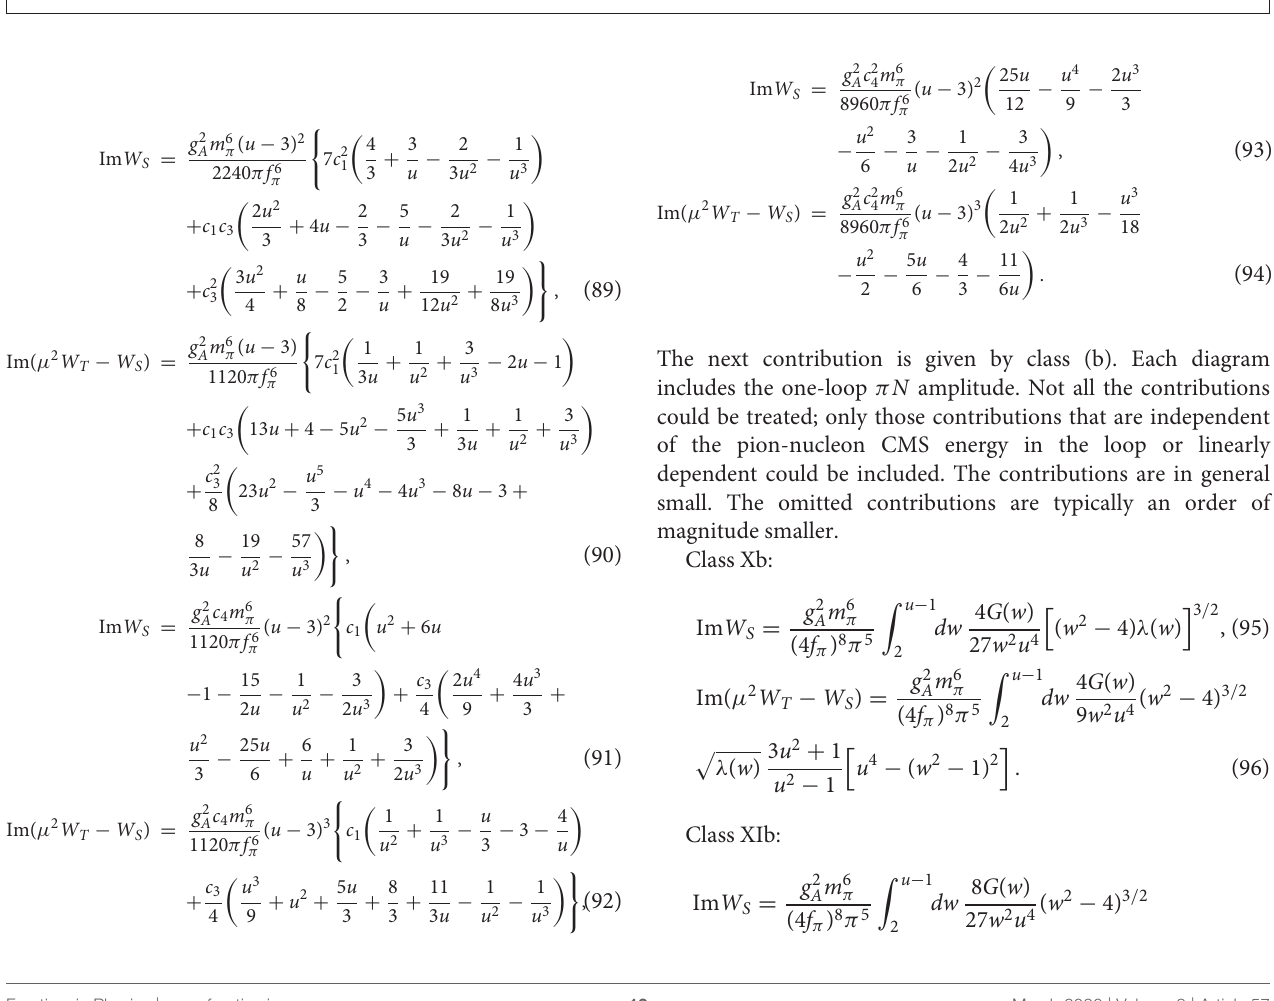
FIGURE 8 | N 5 LO 3 π -exchange contributions to the NN interaction. (A) Diagrams proportional to c 2 i . (B) Diagrams involving the one-loop π N amplitude. Notation as in Figure 3 . Reprinted figure with permission from Entem et al. [48], copyright (2015) by the American Physical